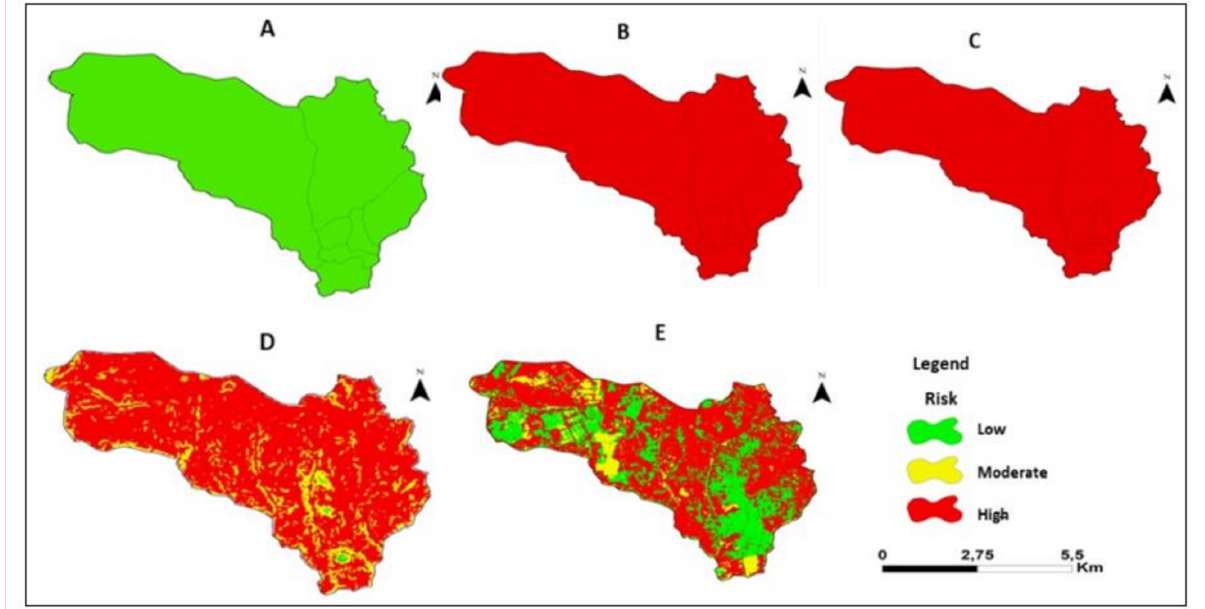
Figure 9. Risk for malaria. ( A ). Distance to waterbodies. ( B ). Distance to roads. ( C ). Pop. Density. ( D ). Malaria prevalence. ( E ). NDVI for Sussundenga Village. Figure 10 represents the malaria risk map. Neighborhoods of Nhamaraza. Nhamarenza. Chicueu. and Unidade have higher incidence of malaria in the northeast and southeast areas. In contrast. the central eastern part. had a lower risk of malaria. in the neighborhoods 25 de Junho 1. 25 de Junho 2. and 7 de